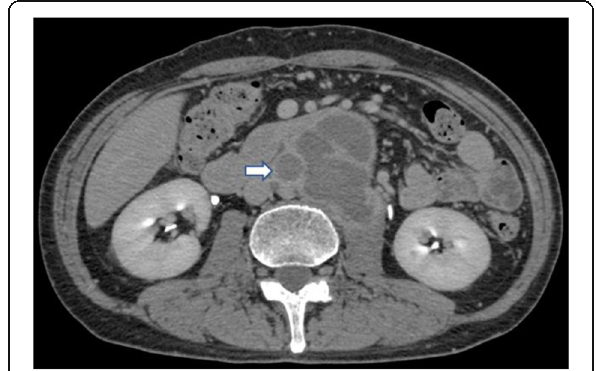
Fig. 3 Follow-up enhanced computed tomography at 1 month after the initial examination showing total occlusion of the abdominal aorta